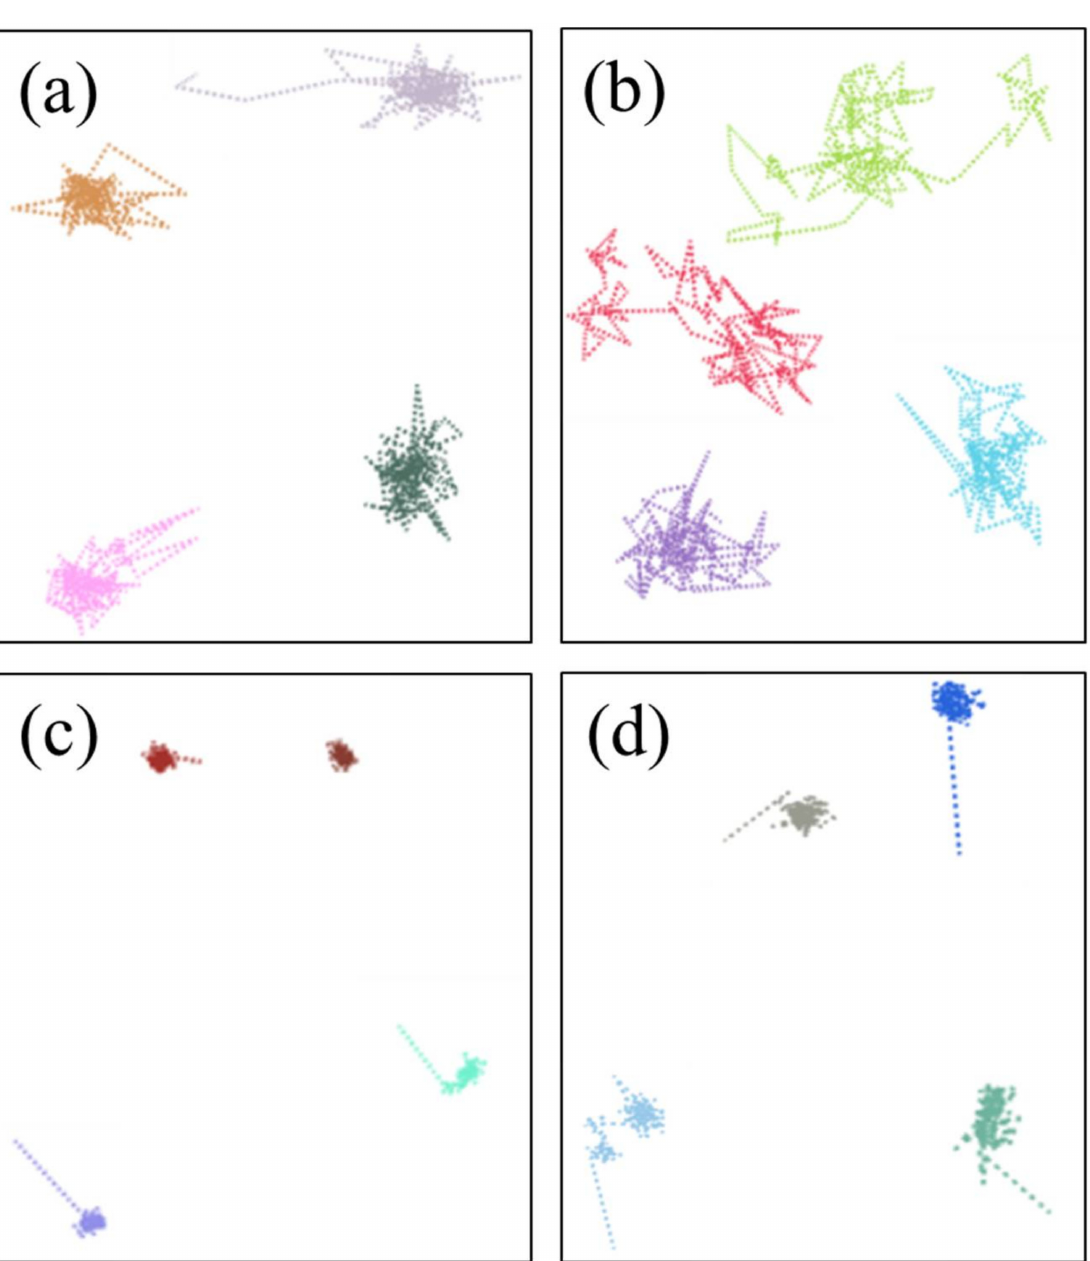
Figure 14. The motion trajectories of the cyclohexane molecules in the NBR: ( a ) 298.15 K/under the free state; ( b ) 383.15 K/under the free state; ( c ) 298.15 K/under the compression state; ( d ) 383.15 K/under the compression state. (Each color plot represents a motion trajectory of cy- clohexane